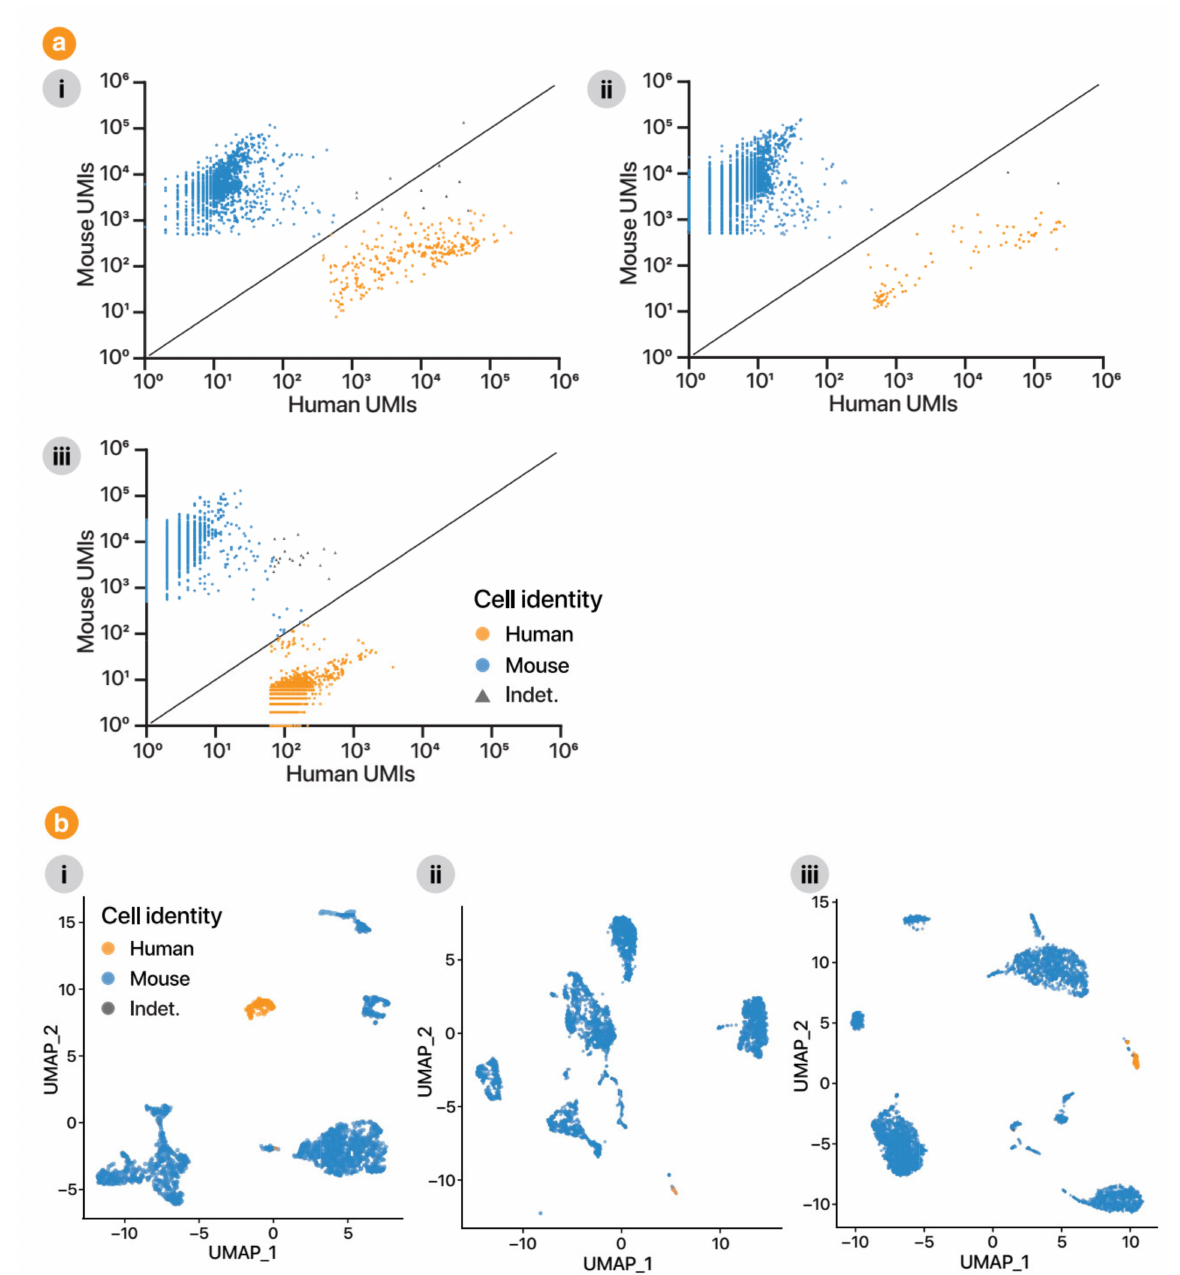
Figure A8. Classification of mouse versus human cells. ( a ) Classification by relative UMI counts. These plots the number of mouse UMIs to human UMIs for each cell (barcode) in the mouse model samples: ( i ) MsPrim, ( ii ) MsSec, and ( iii ) MsBlood. This demonstrates that there is little overlap of the two groups of cells when considering the proportion of UMIs mapped to mouse and human genomes for classification of host species cells. Note: Cells with UMIs mapped exclusively to one or the other reference genomes could not be plotted in log scale, and are therefore omitted from these plots. ( b ) Classification by gene expression. Using only one-to-one orthologous genes to classify the cells, the UMAP plot clearly indicates human cells clustering away from mouse cells. The colour represents the identity of the cell as determined by relative UMI counts (as in [a] above). These UMAP plots demonstrate a high degree of agreement between the two classification strategies, thus validating the cell type identification. ( i ) UMAP plot for MsPrim sample. ( ii ) UMAP plot for MsSec sample. ( iii ) UMAP plot for MsBlood sample. Abbreviations: Indet.,